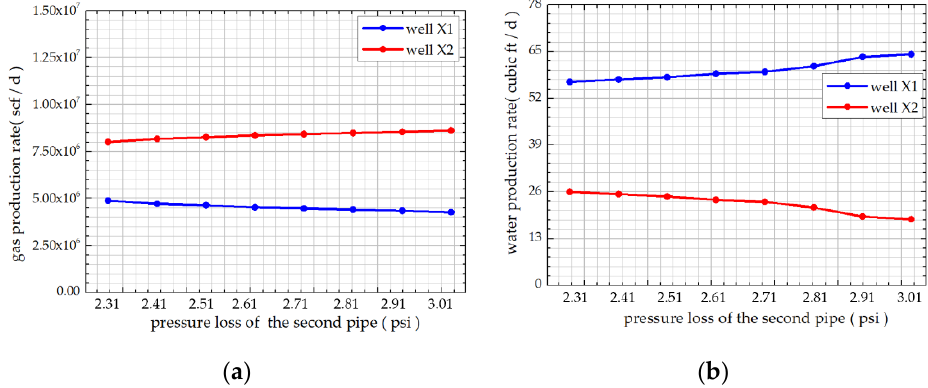
Figure 17. Calculation results under different pressure loss combinations: ( a ) gas production rate; ( b ) water production rate.